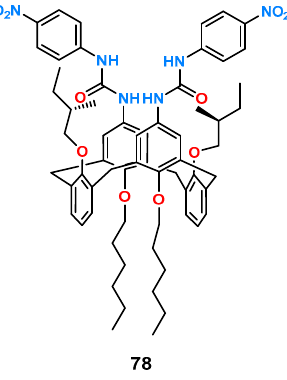
Figure 27. C 2 -Symmetrical calixarene diurea receptor 78.